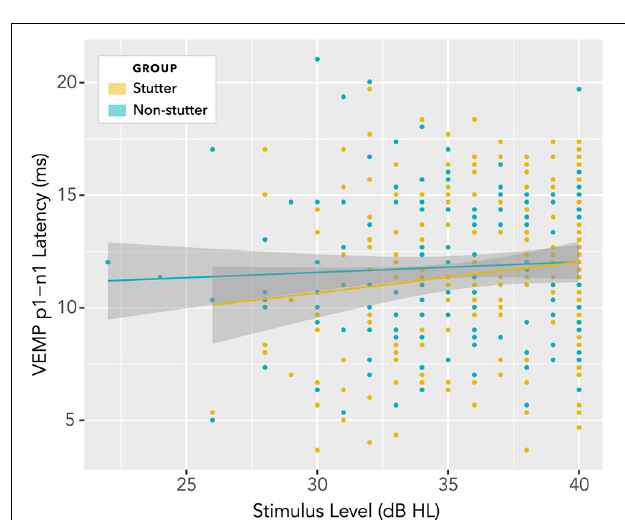
FIGURE 13 | Variation of VEMP p1-n1 latency with stimulus level. There is no statistically significant interaction, and no indication of a group